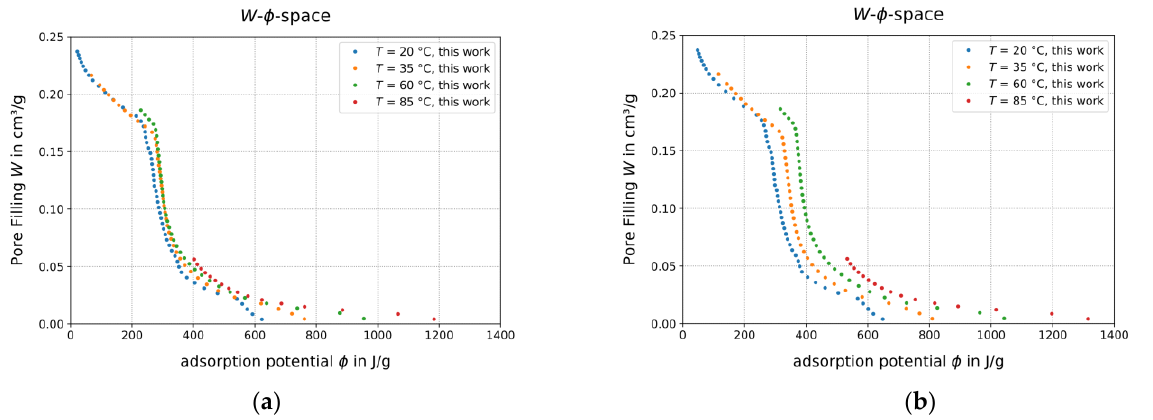
Figure 9. ( a ) Measured isotherms in W - ϕ -space, adsorption potential according to Polanyi. ( b ) Measured isotherms in W - ϕ -space, adsorption potential according to Kohler.